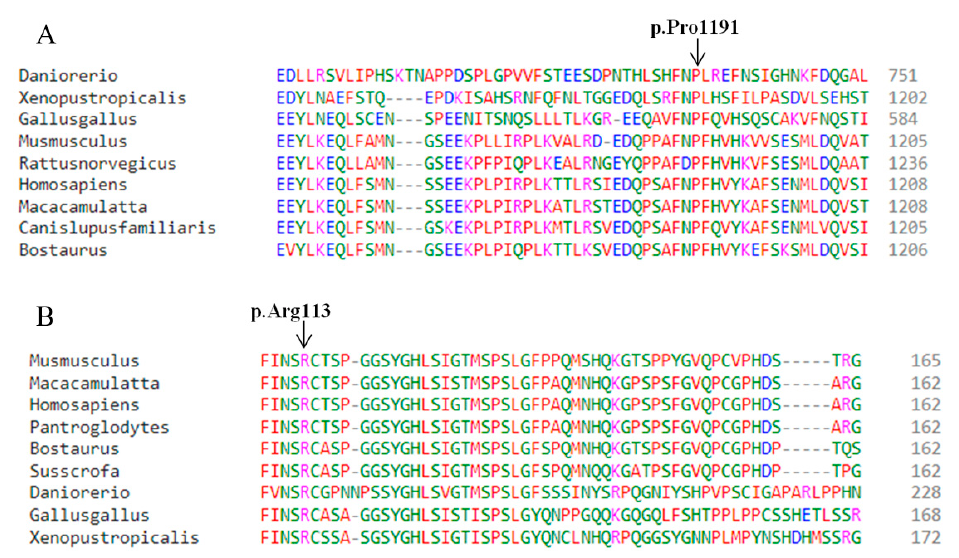
Figure 4. Conservation profile of KIAA0825 and GLI1 across several species predicted by Clustal Omega. ( A ) Conservation profile of Pro1191 (KIAA0825). ( B ) Conservation profile of Arg113 (GLI1).